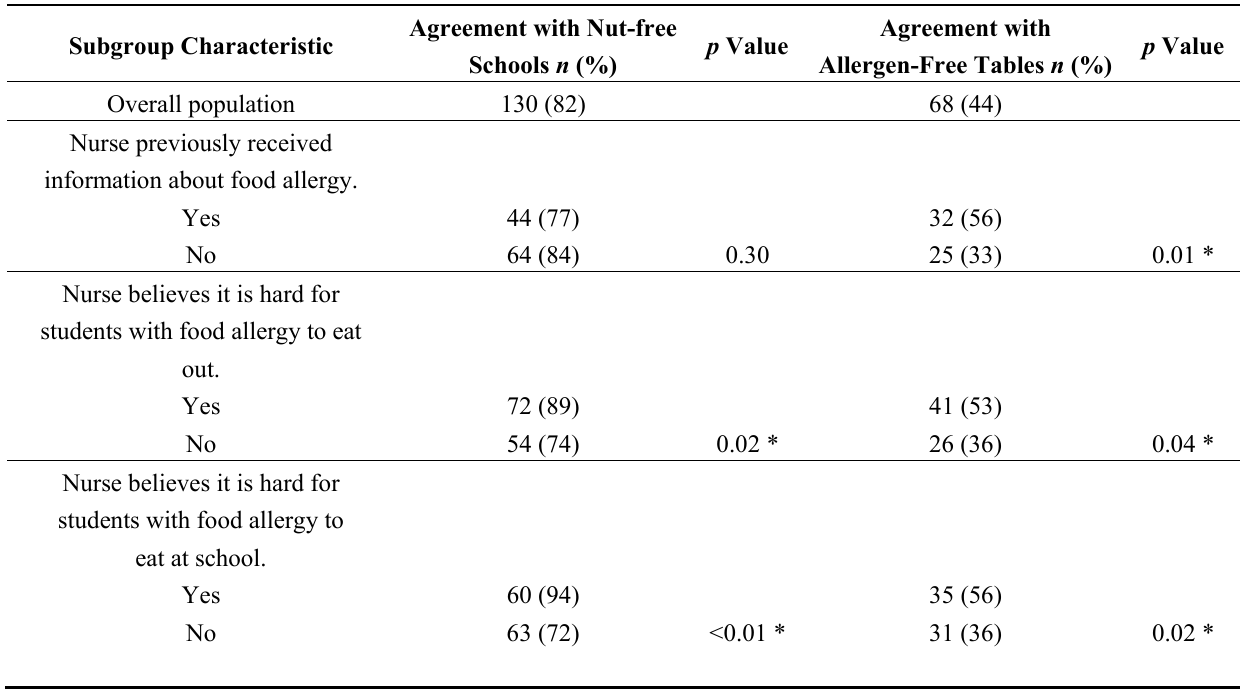
Table 5. Predictors of nurse school policy